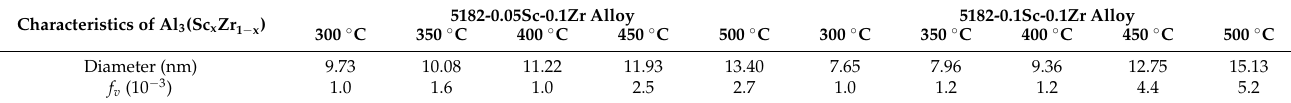
Table 5. Characteristics of Al 3 (Sc x Zr 1 − x ) dispersoids.